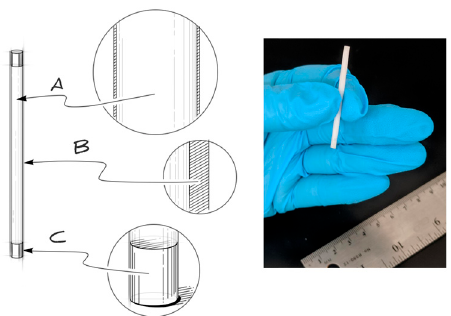
Figure 1. (Left) A schematic of a PCL reservoir-style device for delivery of TAF, which comprises a formulated drug core (A) encapsulated by a rate-controlling PCL membrane (B). The device is end-sealed using PCL material (C) for trocar compatibility. (Right) A digital camera image of the biodegradable implant.